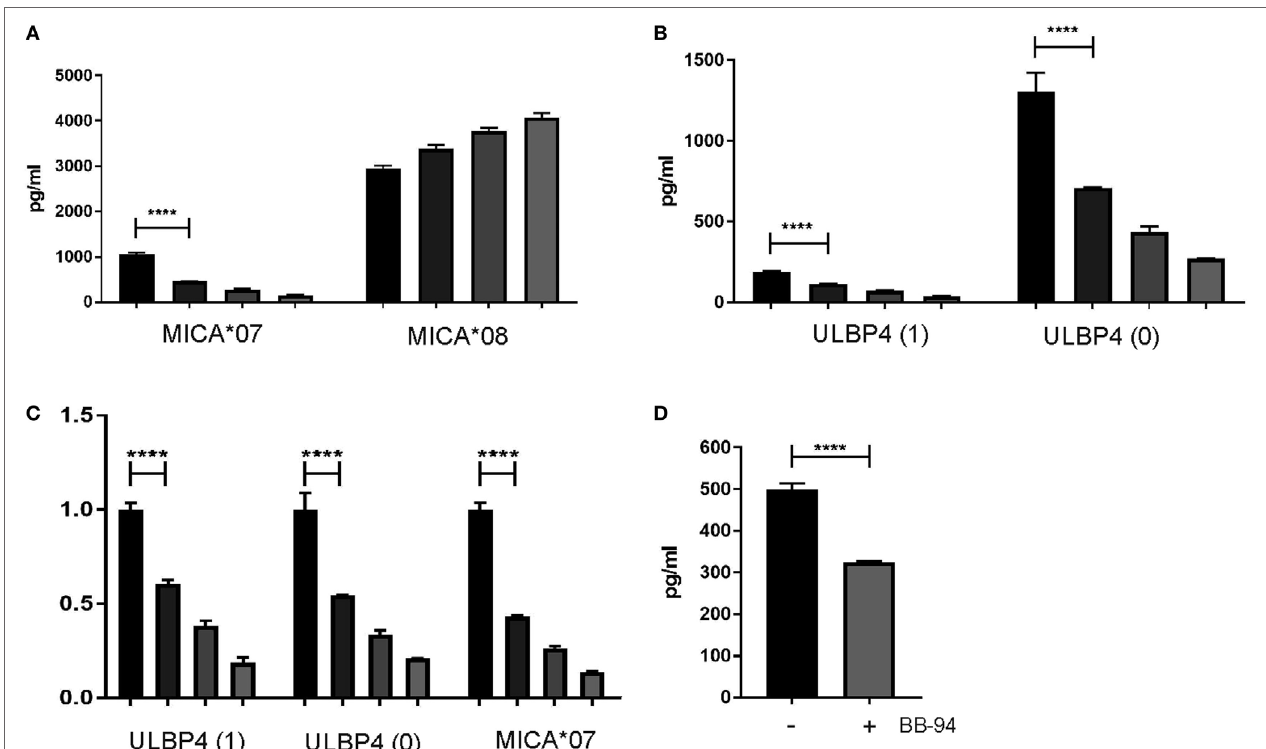
FigUre 5 | Proteolytic release of soluble ULBP4 (sULBP4). (a–c) C1R cells (1 × 10 6 cells/ml) stably transfected with ULBP4 isoforms 0, ULBP4 isoform 1, MICA*07, or MICA*08, respectively, were cultivated in the presence of various concentrations of batimastat for 42 h (from left to right: 0, 0.2, 1, and 5 µM batimastat). Subsequently, supernatants were analyzed for concentrations of (a) sMICA or (B) sULBP4. (c) Relative changes of concentrations (mean ± SD) as depicted in panels (a,B) with values for control-treated samples (0 µM batimastat) set as 1. One representative experiment out of three is shown. Statistical significance was only assessed for differences between samples treated with 0 versus 0.2 µM batimastat using a one-way ANOVA with Tukey’s multiple comparisons test (**** p < 0.0001). (D) Detection of sULBP4 in supernatants of HeLa cells grown for 65 h in absence or presence of 10 µM batimastat (BB-94). Statistical significance was calculated using unpaired t -test (**** p <